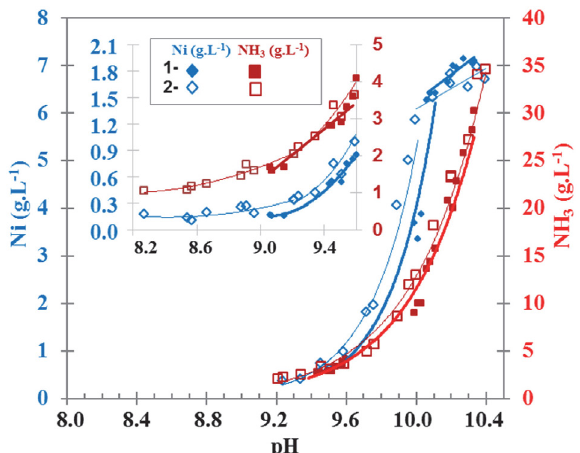
Figure 4. Profile of nickel and ammonia dissolved versus pH at 25 °C in the mini-column (Stage 02). Product-liquor distillation with (1–) and without (2–) CO 2 -reach solution. Ni/S 3.32, Ni/[SO 42– ] 6.82, Ni/ [S 2 O 32– ] 4.25, NH 3 /CO 2